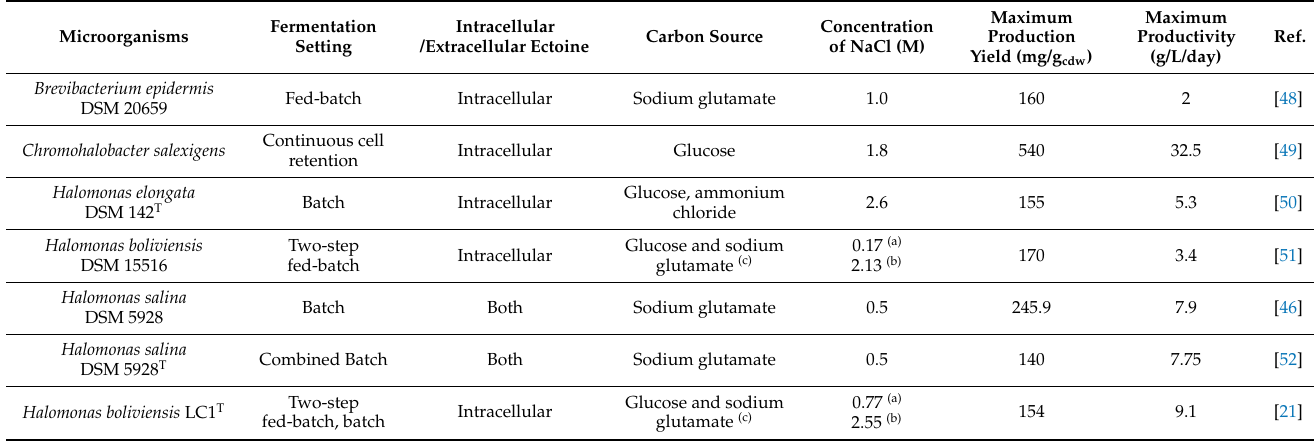
Table 3. Large-scale production of ectoine by different microbial